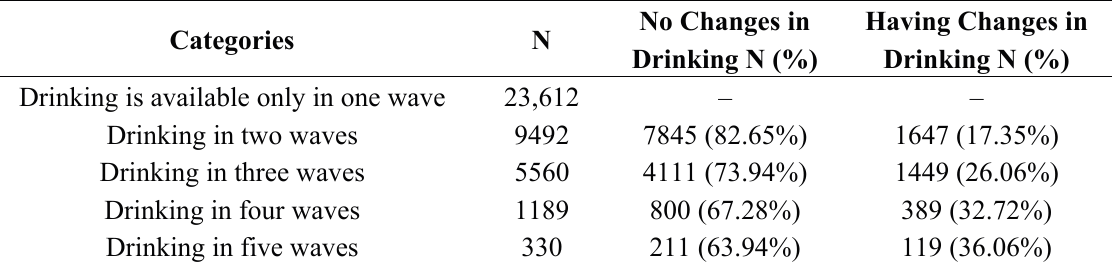
Table A4. Variation in drinking for five